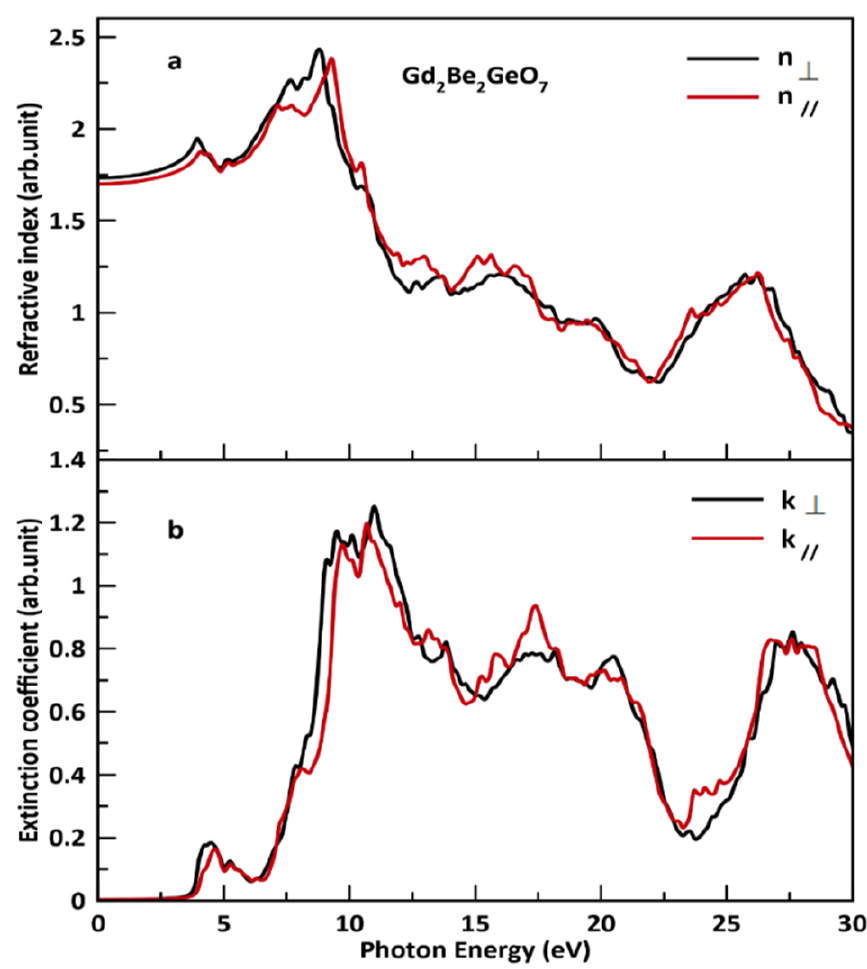
Figure 8. ( a ) Calculated refractive index n( ω )and ( b ) extinction coefficient k( ω )for Gd 2 Be 2 GeO 7 compound in both parallel and perpendicular directions .